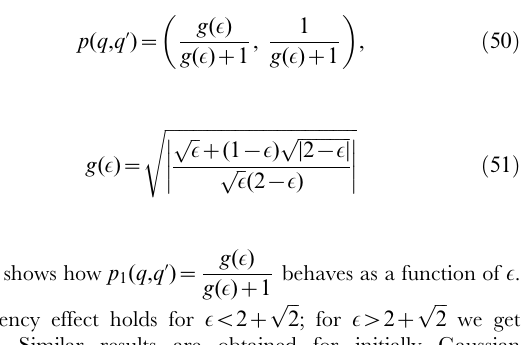
p ffiffiffi 2 we get